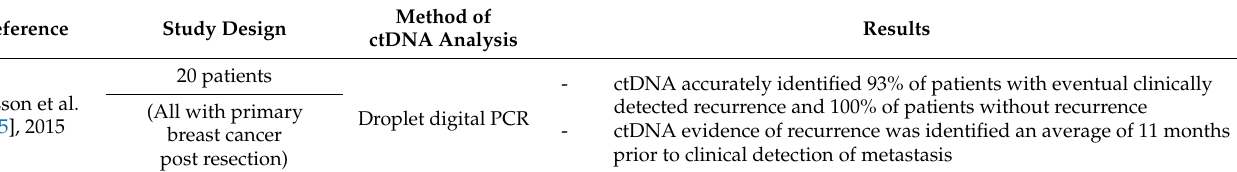
Table 3. Summary of studies exploring the use of ctDNA for predicting breast cancer